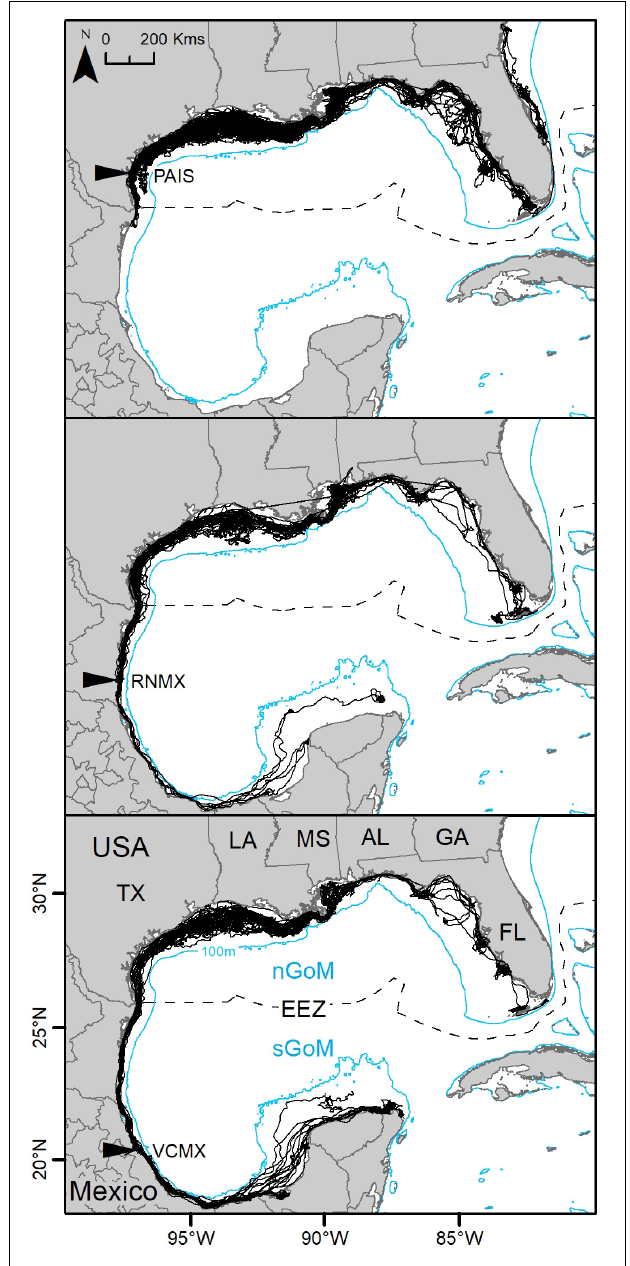
FIGURE 1 | Switching state-space model-derived tracks for 117 post-nesting female Kemp’s ridley sea turtles tracked from the primary and major secondary nesting beaches: Padre Island National Seashore, Texas, United States (PAIS); Rancho Nuevo, Tamaulipas, Mexico (RNMX); Tecolutla, Veracruz, Mexico (VCMX). The Exclusive Economic Zone (EEZ) demarcates the division between the northern Gulf of Mexico (nGoM) and southern Gulf of Mexico (sGoM). Transmitters were deployed between 2010 and